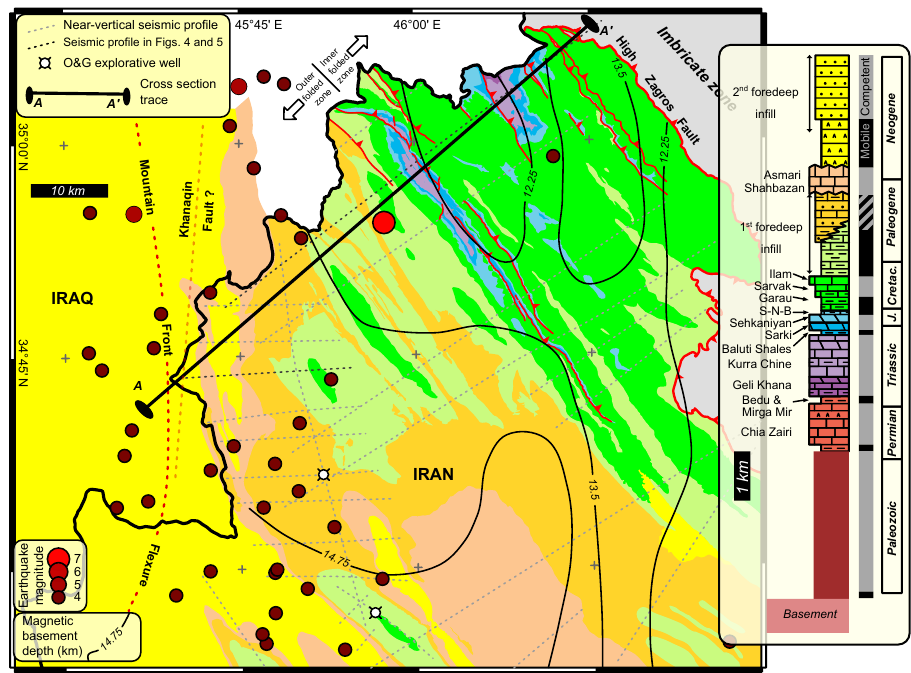
Figure 3. Geological map of the NW portion of the Lurestan region (source: National Iranian Oil Company and original field mapping) showing (i) November 2017 earthquakes; (ii) traces of near-vertical seismic profiles and wells used to constrain the geological cross section of Fig. 6 (profiles shown in Figs. 4 and 5 are in black); (iii) magnetic basement depth (Teknik and Ghods, 2017), and (iv) a trace of the geological section in Figs. 4 and 5. The inset shows the stratigraphic succession of the area, with thicknesses for the Mesozoic to Cenozoic stratigraphic units computed from original field data. Thickness for the Paleozoic to Lower Triassic is taken from the literature on the geology of Iraq (Jassim and Goff, 2006). The supposed trace of the Khanaqin fault is from Lawa et al.